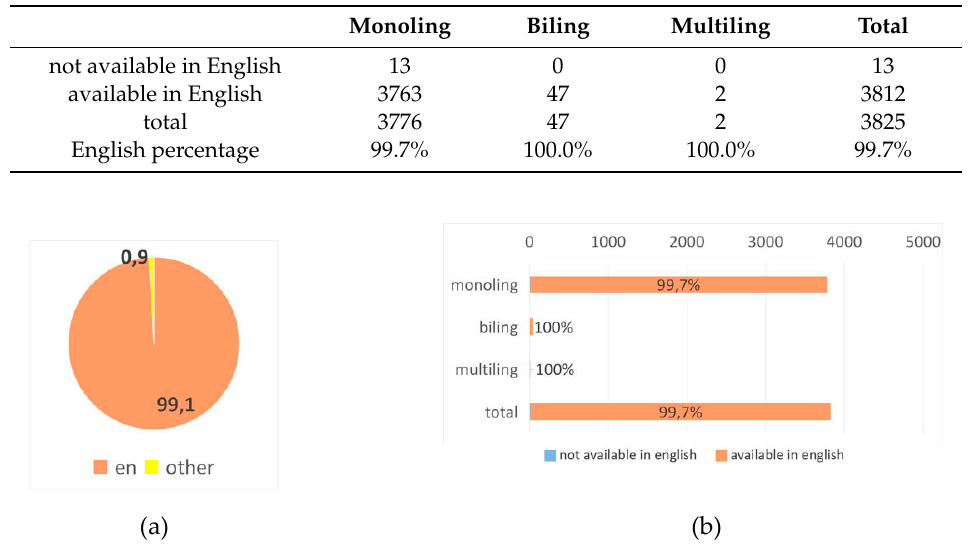
Figure A14. Visualization of the results for domain ie. ( a ) Primary languages pie chart and ( b ) English language availability bar chart.